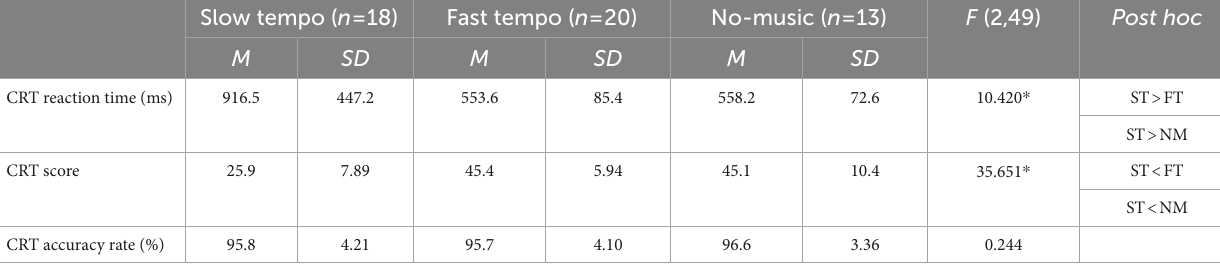
TABLE 1 Mean and standard deviation of variables in choice reaction time (CRT) task.